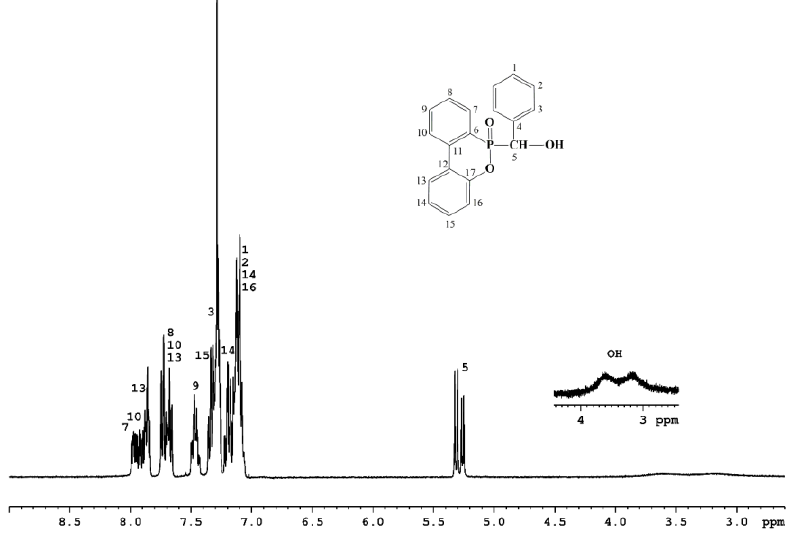
Figure 1. 1 H NMR spectrum of PFR.